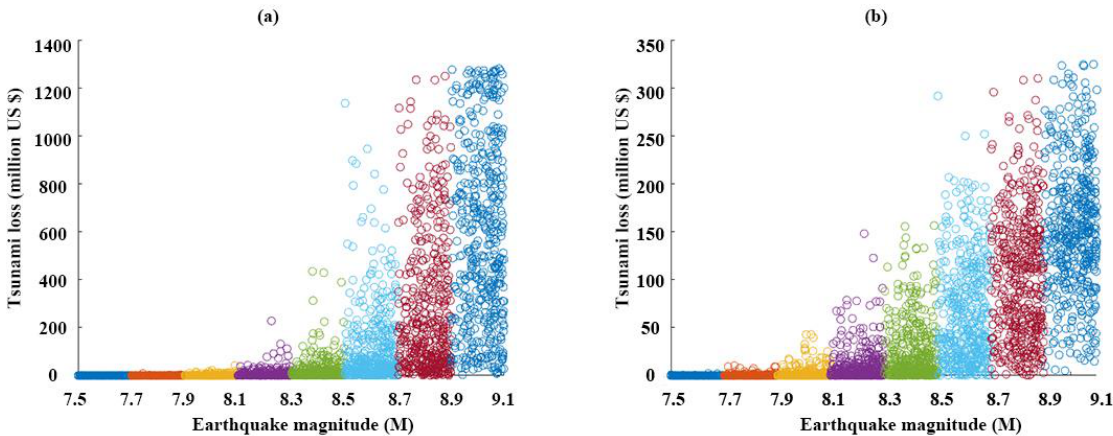
Figure 4. Maximum on-shore tsunami amplitude plot for ( a ) Iwanuma and ( b ) Onagawa.